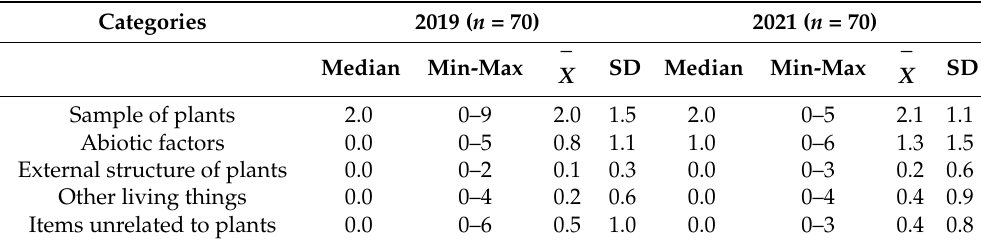
Table 3. Statistical descriptors of the frequency of the pictorial categories under study in the first drawing activity (2019), as well as two years later.